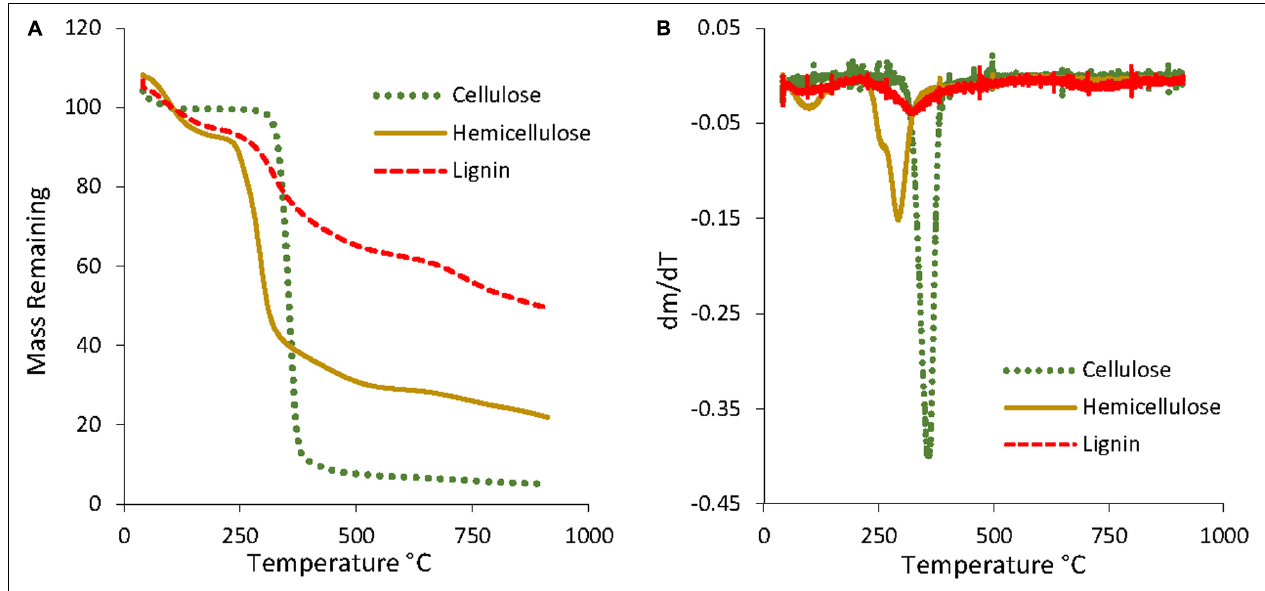
FIGURE 5 | TG (A) and DTG (B) curves of cellulose, hemicellulose, and lignin.